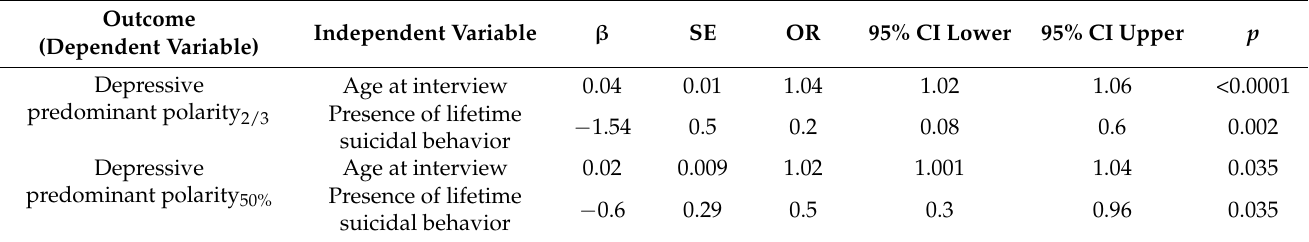
Table 3. Logistic regression of clinical characteristics associated with predominant polarity subgroup defined according to the 50% or 2/3 of prevalent episodes criterion.